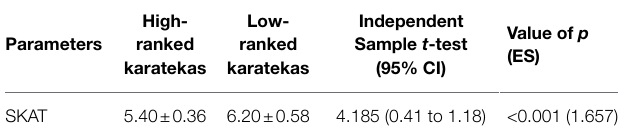
CI, confidence interval; s, second; and SKAT, specific karate agility test.